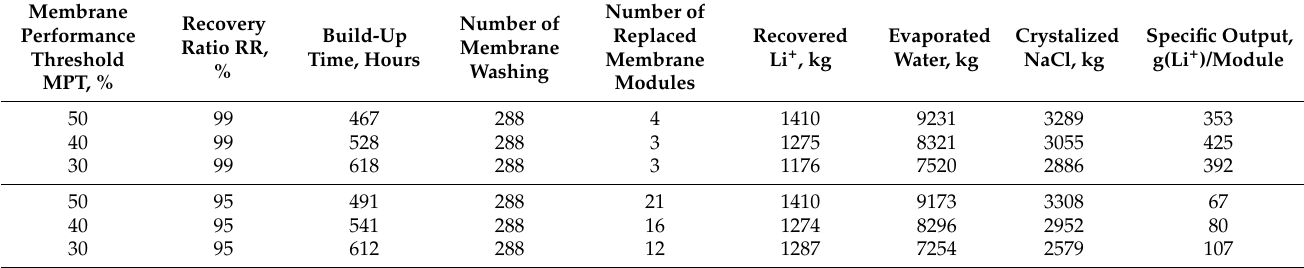
Table 7. Comparison of different configurations and performance of MD process reported in the literature and inthis work (two months of operation). Simulation conditions: RR = 50%, S = 2.5 m 2 , CF = 20, ER(Li + ) = 90%. MD Process Configuration Temperature Mode (Hot/Cold side)